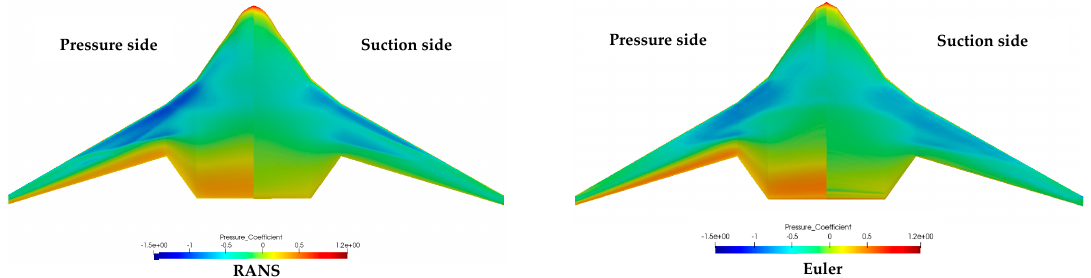
Figure A14. Pressure coe ffi cients for RANS and Euler simulations at AoA = -1 deg.